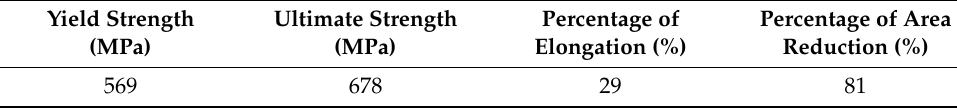
Figure 1. ( a ) Dimensions of the compact tension (CT) specimen. All units are in mm. ( b ) Macrographic photo of the CT specimen. The unit is in cm. ( c ) Schematic of positions of the CT specimens’ sampling. Table 1. Mechanical properties of 2.25Cr1Mo0.25V